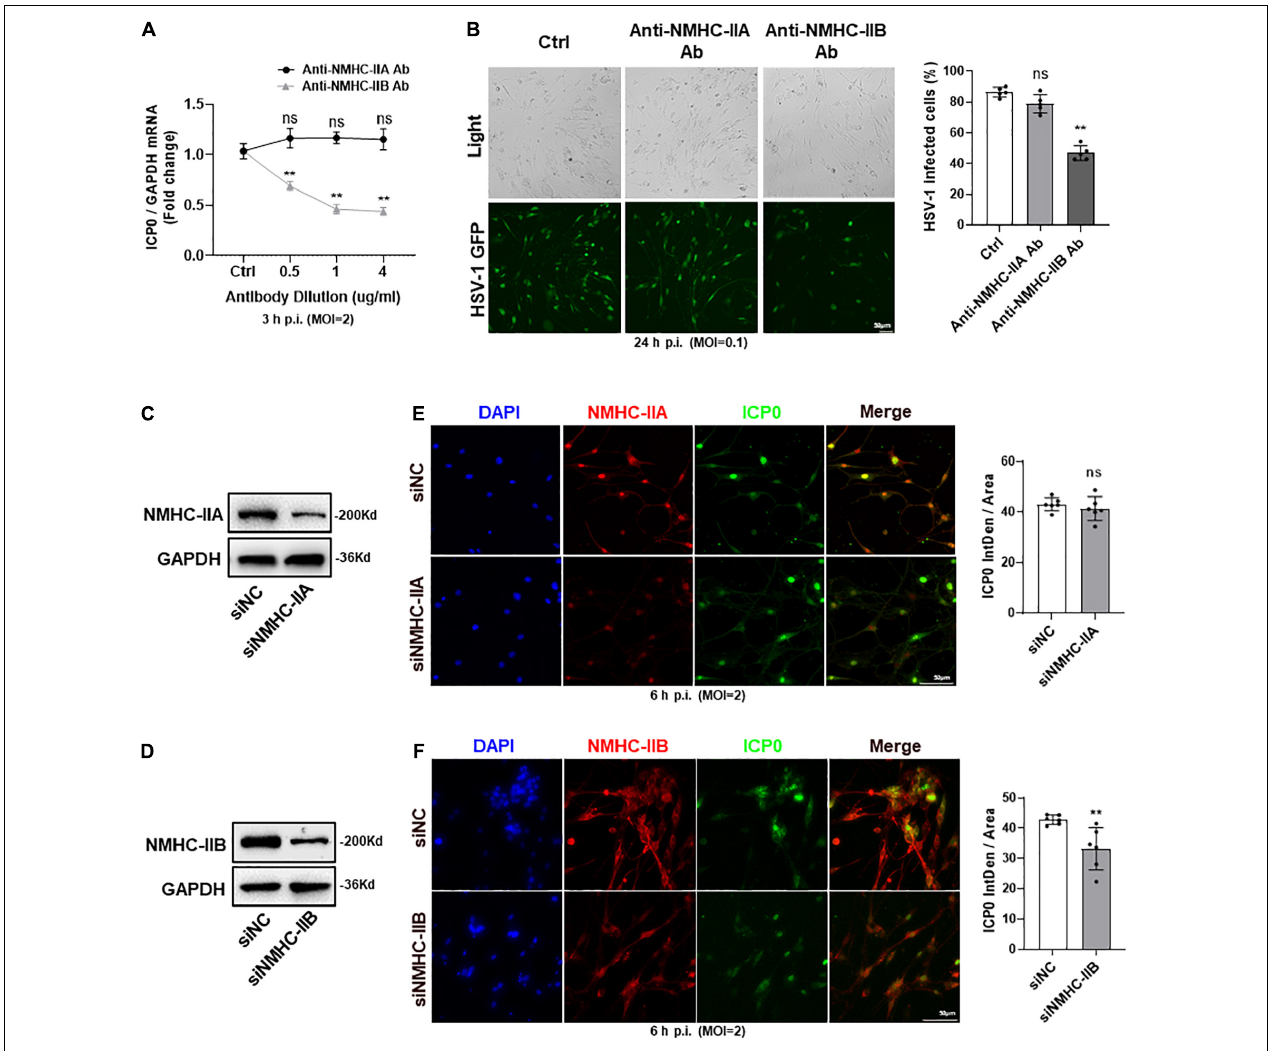
FIGURE 4 | NMHC-IIB of gB receptors mainly mediated the entry of HSV-1 into TG neurons. (A,B) Cultured TG neurons were pretreated with anti-NMHC-IIA Ab or anti-NMHC-IIB Ab at indicated concentrations ( µ g/ml) before exposure to HSV-1 strain McKrae or HSV-1-GFP at different MOIs. Cultured TG neurons with the same concentration of antibody diluent were used as control (Ctrl). ICP0 mRNA levels (A) at 3 h p.i. ( n = 5) and the percentage of HSV-1-GFP infected cells (B) at 24 h p.i. ( n = 5) were assayed. HSV-1 infection was significantly reduced in the anti-NMHC-IIB Ab treatment group compared to Ctrl, while there was no change in the anti-NMHC-IIA Ab treatment group. (C,D) NMHC-IIA (C) or NMHC-IIB (D) protein levels were knocked down in cultured TG neurons transfected with targeted siRNA. (E,F) Cultured TG neurons infected with HSV-1 after siRNA knockdown. At 6 h p.i., immunofluorescence analysis of ICP0 expression shows that entry